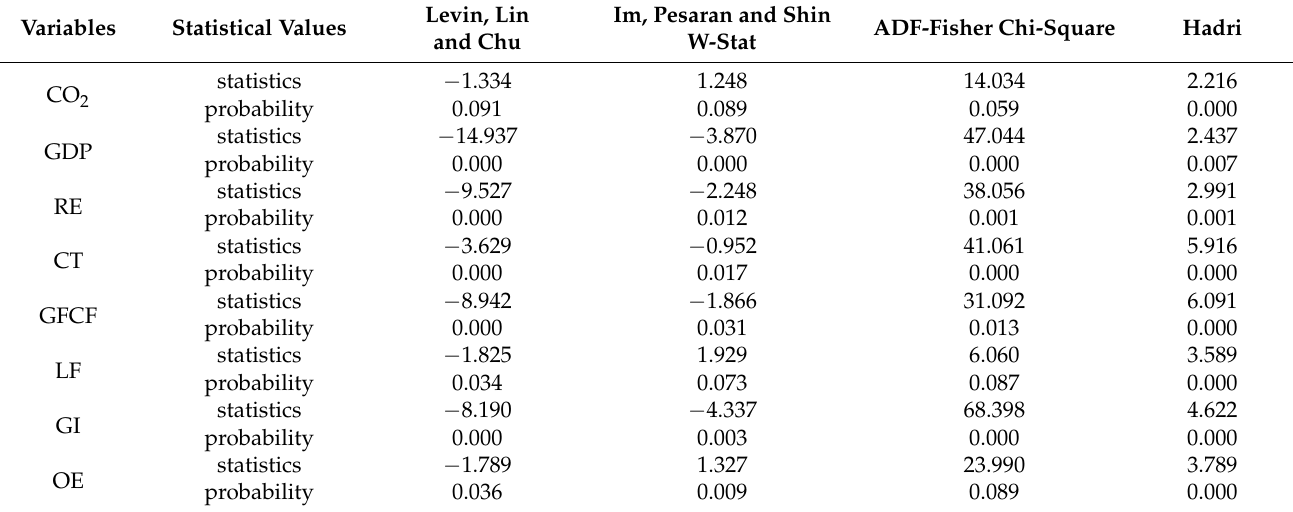
Table 3. The empirical results of data stationarity using the panel unit root test (at 1st